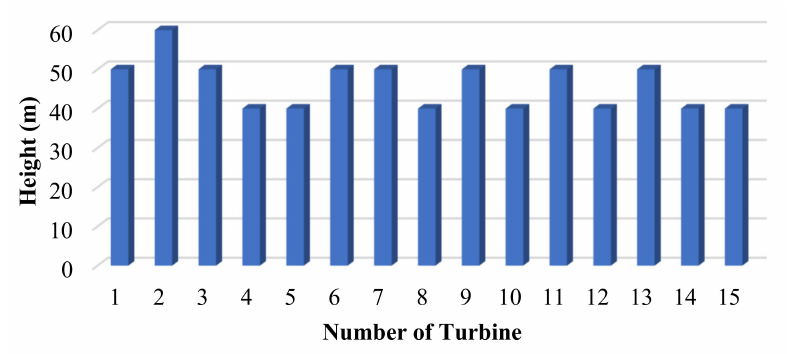
Figure 10. Height of each turbine in Case 2. Table 7. Turbine coordinates in Case 2.